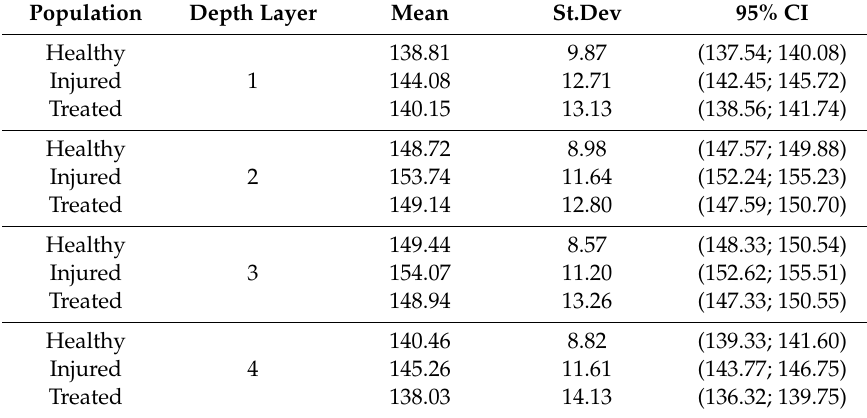
Figure 7. Interaction Plot showing the brightness distribution by population and the depth layer separately for the three corneal populations. Table 2. Mean, St.Dev (standard deviation), and 95% CI for each depth layer. The set of brightness values analyzed in the healthy corneal population were defined as threshold values for the control sample.